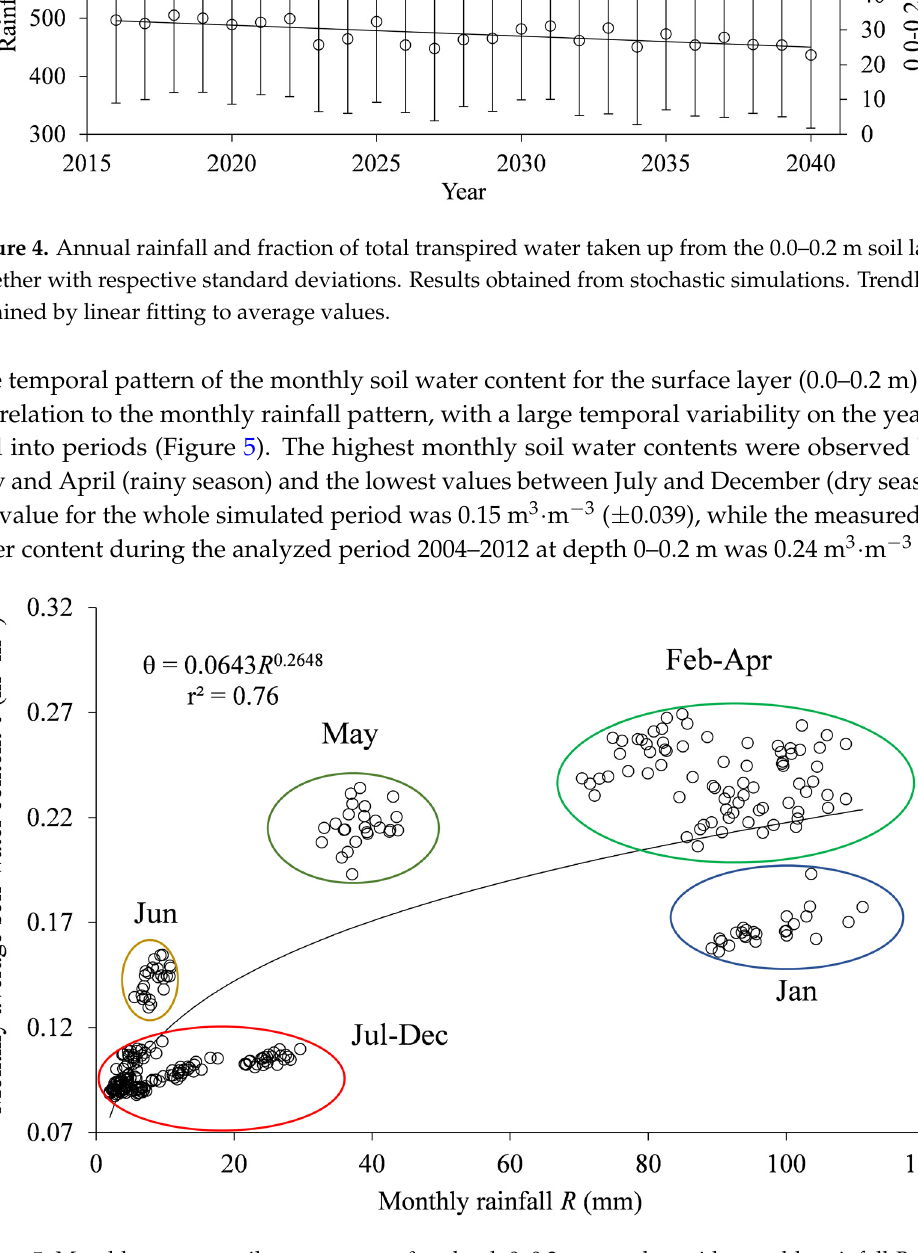
Figure 5. Monthly average soil water content at depth 0–0.2 m, together with monthly rainfall R . r 2 is the coefficient of determination.